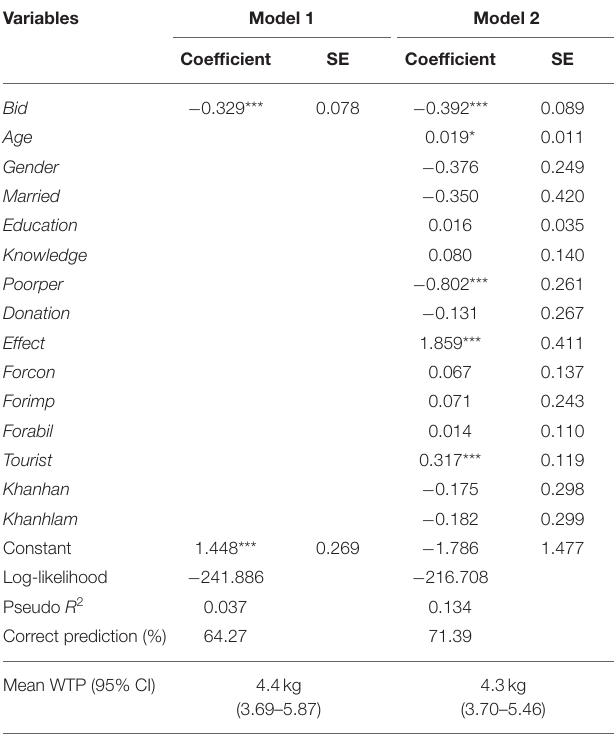
TABLE 5 | Logit analysis of willingness to pay for the UMH conservation